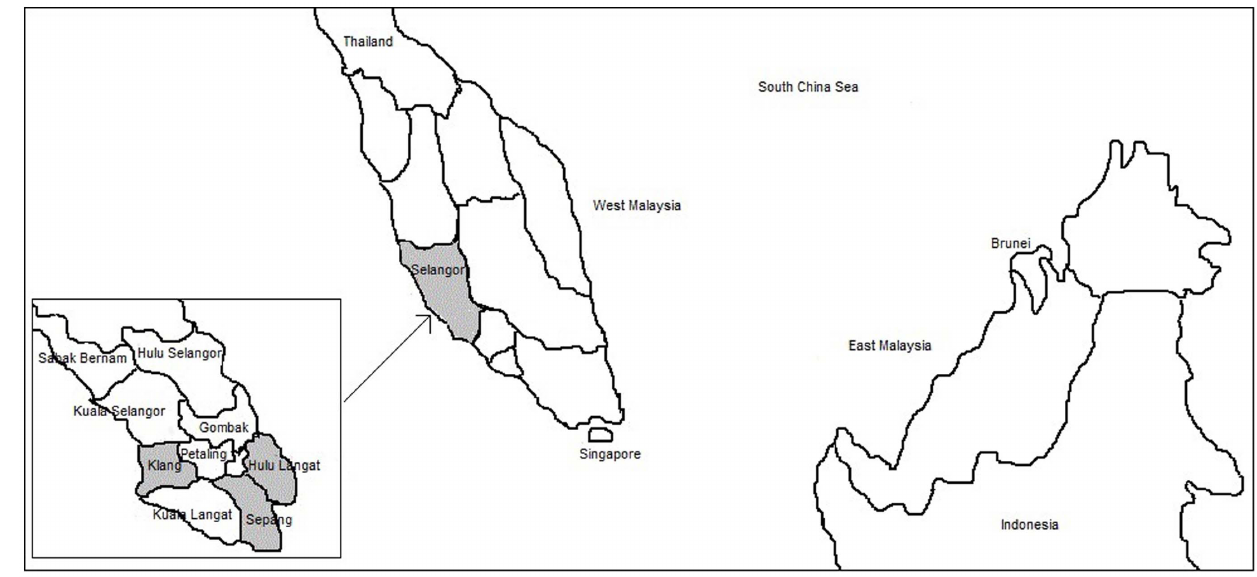
Figure 1. The map of Malaysia. The above figure shows the map of Malaysia. The area highlighted in grey is the state of Selangor. The enlarged view of the nine districts in Selangor is also shown. The three districts where the study was done are also highlighted in grey.